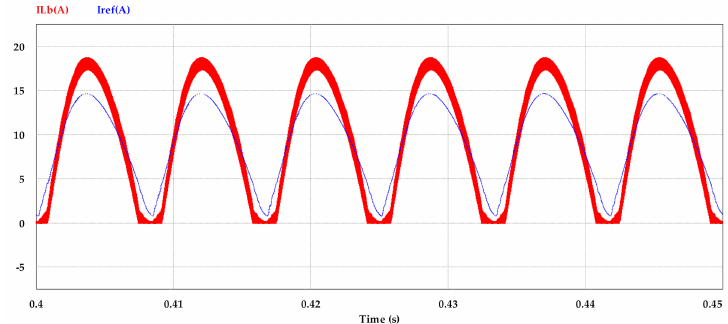
Figure 24. Waveforms of the inductor and reference currents with the PI current controller.